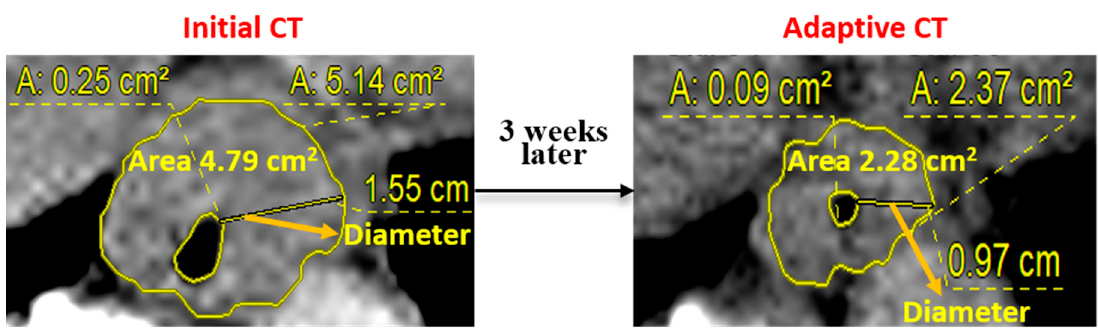
Figure 1. Measurement of region of interest (ROIs) based on initial computed tomography (CT) and adaptive CT scans. The area and maximal diameter of the esophageal lesion in the initial CT scan was 4.79 cm 2 and 1.55 cm, respectively. In the adaptive CT scan, the corresponding values were 2.28 cm 2 and 0.97 cm, respectively.